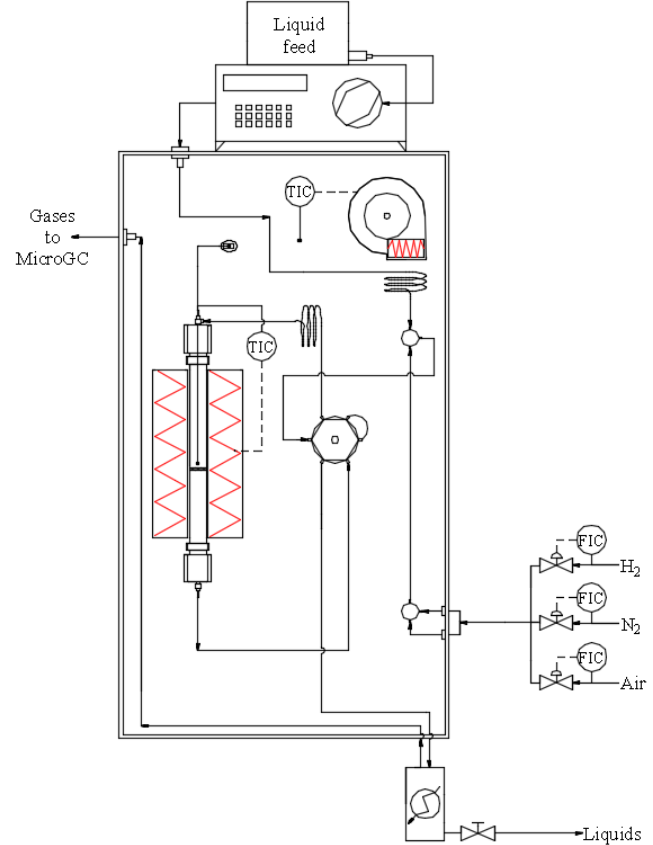
Figure 9. Schematic diagram of the reaction system.